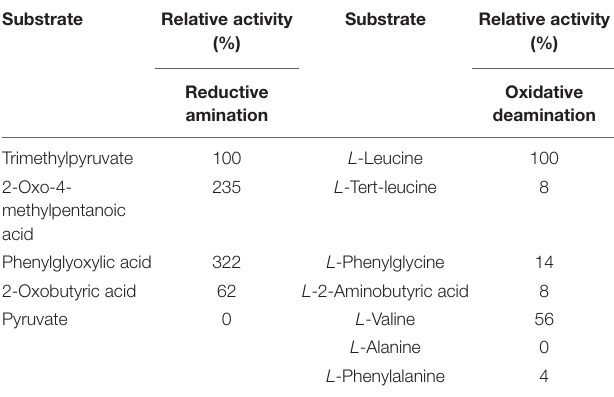
deamination. Substrate